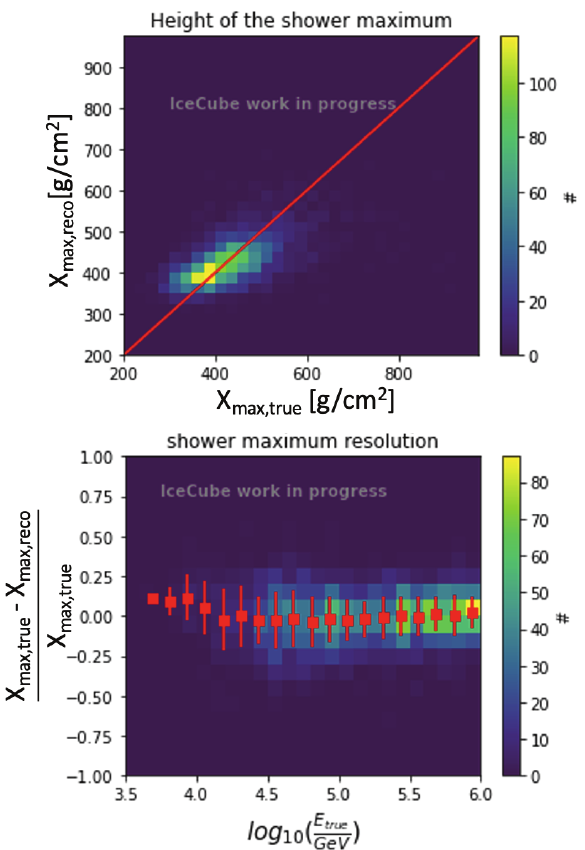
Figure 14: Preliminary IceAct graph neural network re- construction result on the air shower maximum, trained with di ff erent elementary groups (H, He, N, Al and Fe) [24] using Sibyll2.1 [4] simulations. (Top) X max , true vs. X X max , reco . . (Bottom) Relative max resolution as a function of